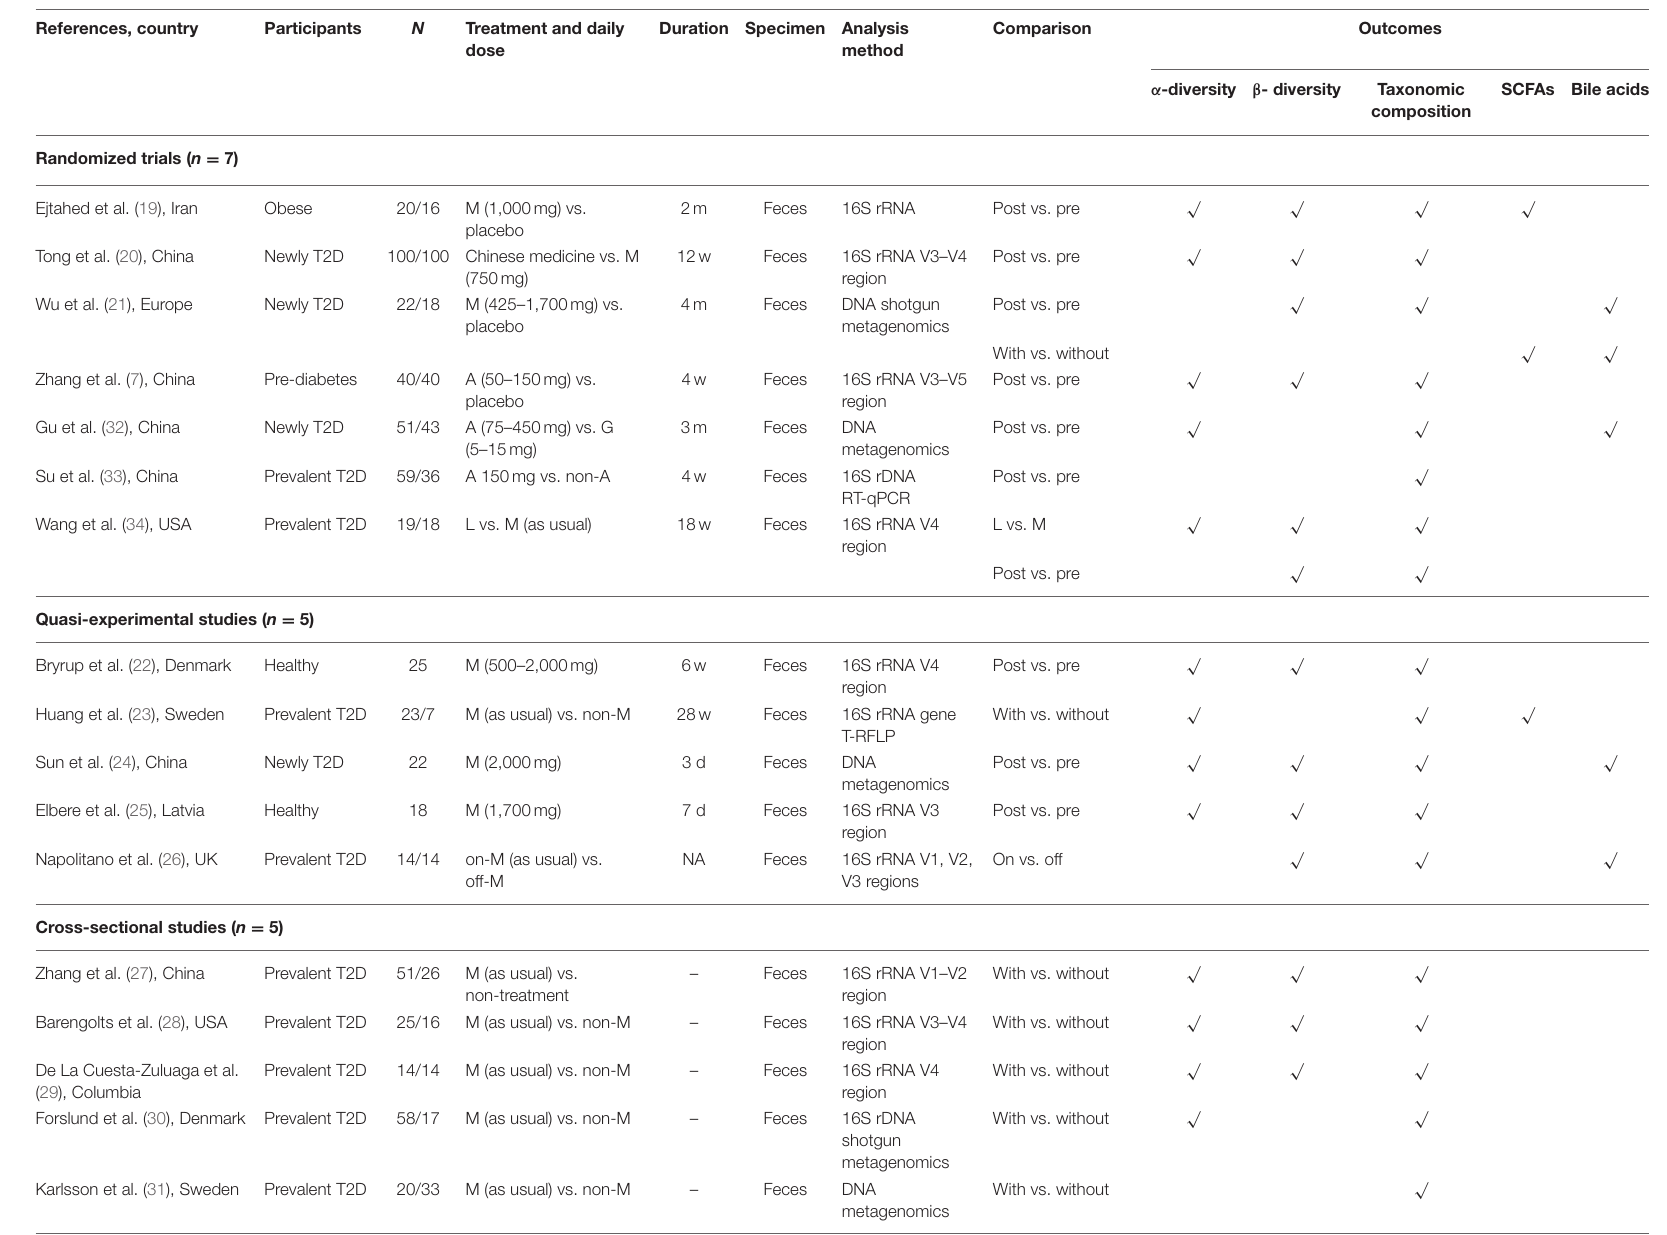
TABLE 2 | Characteristics of included human